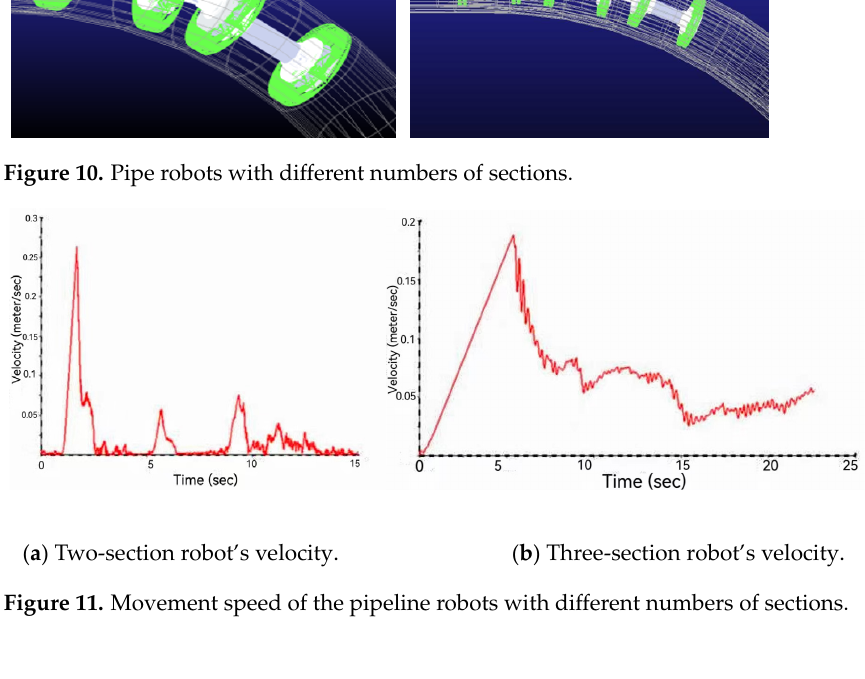
Figure 12 . Contact force of leather bowl with di ff erent numbers of compartments. Through an ADAMS simulation analysis, it could be seen, as shown in Figure 11, that the variation laws of the motion speeds of the two groups of pipeline robots were almost the same. A ff ected by the initial force, the two groups of robots had a uniform increase in speed in the straight pipe. At the moment of entering the curve, due to the contact force and friction force, the speed dropped sharply. After entering the curve, the speed of the robot increased signi fi cantly due to the backlog of pressure and then decreased until it left the pipe. However, the average speed of the two-section robot was 0.12 m/s, and the max- imum speed before entering the bend was 0.27 m/s. The average speed of the three-section robot was 0.08 m/s, and the maximum speed before entering the bend was 0.18 m/s. The movement speed of the three-section robot was much lower than that of the two-section one. As shown in Figure 12, a point was taken at each of the two robot leather bowls for monitoring, and the trend of contact force variation at the leather bowls was approxi- mately the same. However, the contact force at the leather bowl of the three-section pipe- line robot was slightly higher than that of the two-section pipeline robot because of more constraints on the degrees of freedom of the three-section pipeline robot. According to the force formula of robot motion: (cid:4666)𝑃 (cid:2869) − 𝑃 (cid:2870) (cid:4667)𝐴(cid:4666)𝑥(cid:4667) − 𝐹 (cid:3033) − 𝐹 (cid:3050) ± 𝐺𝑠𝑖𝑛𝜃 = 𝑚 𝑑𝑣 𝑑𝑡 (13) where 𝐹 (cid:3033) is the friction of the leather bowl, N; and G is the PIG gravity, N. The increase in the number of segments led to an increase in the overall mass of the robot. At the same time the number of leather bowls doubled, which increased the fric- tional resistance and seriously reduced the robot’s movement speed. Additionally, the universal coupling transferred forces to the rear half of the curve when turning, which